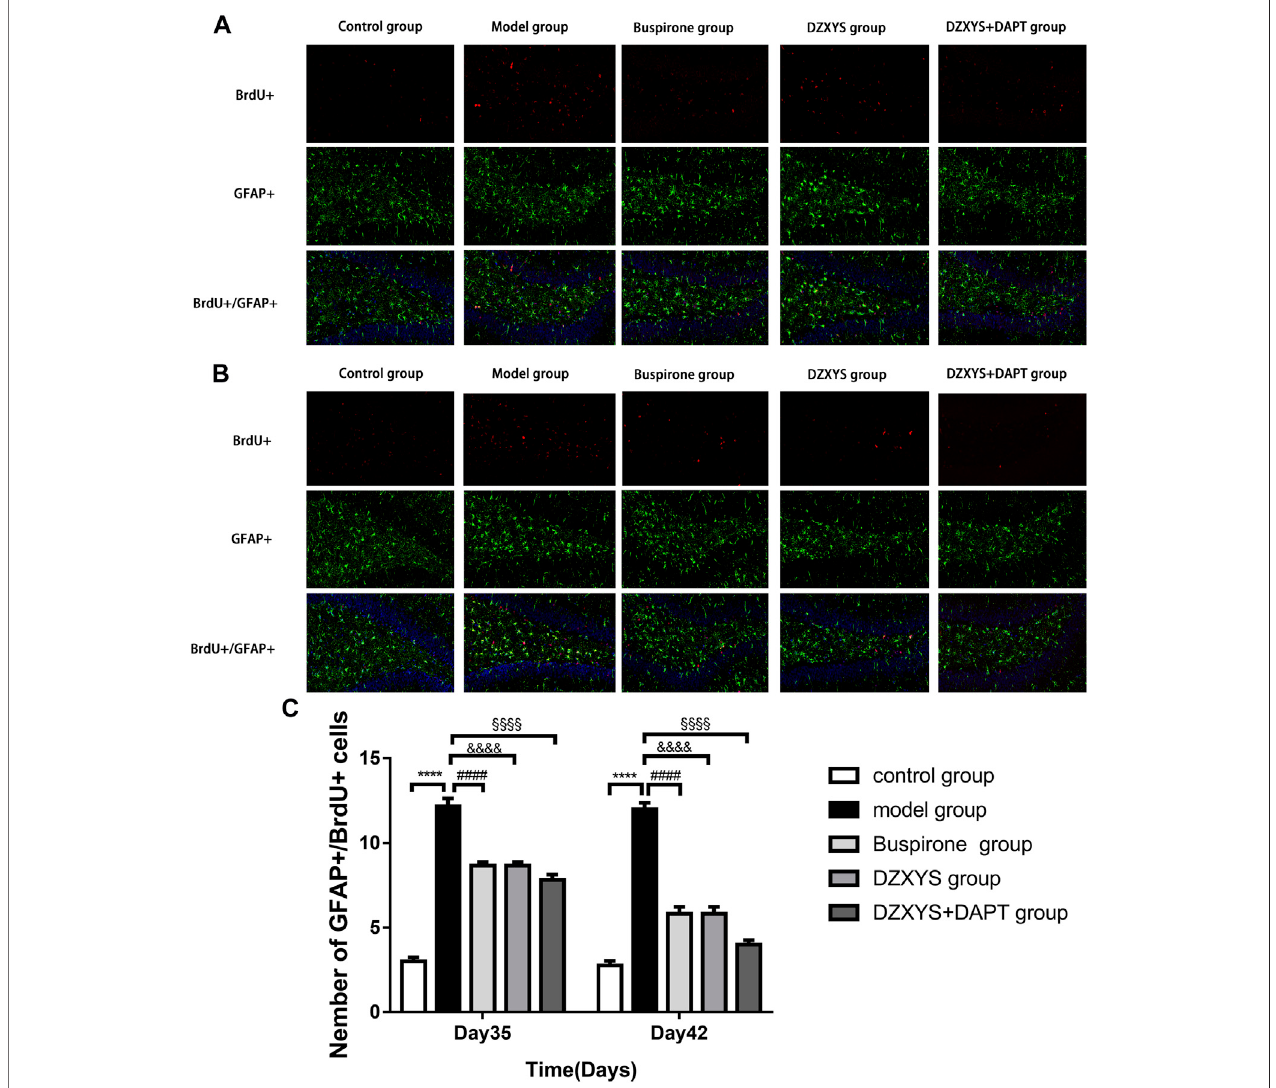
FIGURE9| Thenumberofnewbornastrocytesinthedentategyrusofthehippocampusineachgroup.BrdU(red)labelednewlyformedcells,GFAP(green)labeled astrocytes (A) Theconditionofnewbornastrocytesonthe35thday (B) Theconditionofnewbornastrocytesonthe42ndday (C) ThenumberofnewGFAPpositivecells inthedentate gyrusonthe35thdayand42ndday.**** p < 0.0001,modelgroupvs.controlgroup;#### p < 0.0001,BuspironegroupvsModelgroup;&&&& p < 0.0001, DZXYS group vs. model group; §§§§ p < 0.0001, DZXYS + DAPT group vs model group.